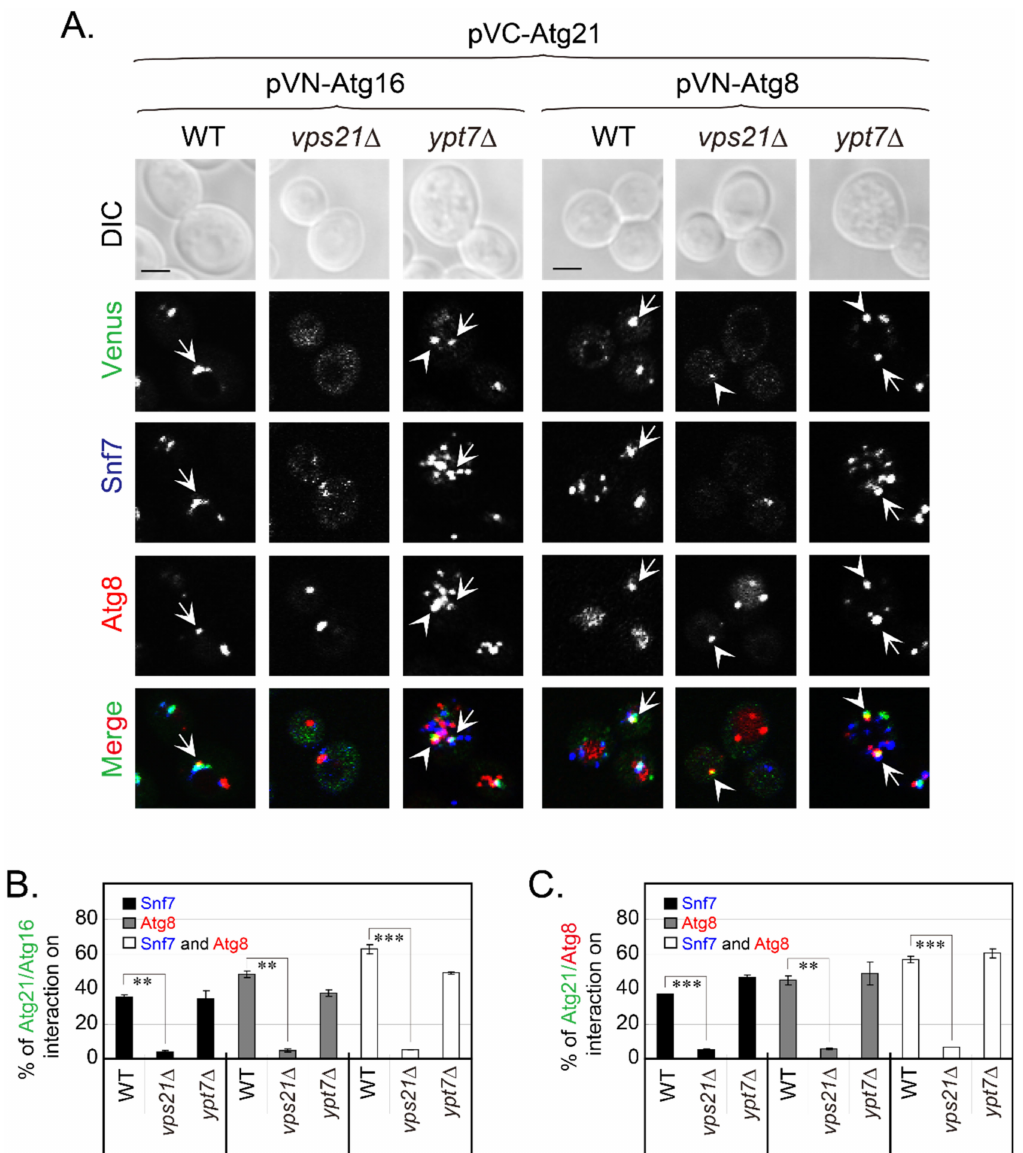
Figure 5. Atg21 interacts with Atg16 and Atg8 in a Vps21-dependent manner. ( A ) Atg21 interacted with Atg16 (left) and Atg8 (right) on Snf7-2xmTagBFP2-labeled endosomes and mCherry-Atg8- labeled PAS/APs under nitrogen starvation, and these interactions were Vps21-dependent. The indi- cated BiFC plasmids were transformed into WT, vps21 ∆ , and ypt7 ∆ cells expressing Snf7-2xmTagBFP2 and mCherry-Atg8, grown, and analyzed for fluorescence, as described in Figure 3A, except that the cells were under nitrogen starvation for 30 min to visualize Atg8-positive dots. Atg21 interacted with Atg16 (left) and Atg8 (right) on endosomes and the PAS/APs in WT and ypt7 ∆ cells, but not in vps21 ∆ cells. The arrows indicate simultaneous interactions on endosomes and the PAS/APs, and the arrowheads indicate interactions on the PAS/APs. Scale bars, 2 µ m. ( B , C ) Quantification of Atg21 interactions on endosomes and/or the PAS/APs with Atg16 ( B ) or Atg8 ( C ). The percentages of Venus-positive puncta (interactions) on endosomes and/or the PAS/APs (panel A ) were quantified and are presented as the mean ± SD. **, p < 0.01; ***, p < 0.001. Vps21 regulates the localization of PI3K complexes, especially PI3K complex II, which further regulates the localization of Atg21. If Vps21 regulates the interaction between Atg21 and Atg16 or Atg8 through PI3K complex II, then the absence of PI3K complex II subunits would result in lost interactions between Atg21 and Atg16 or Atg8. We